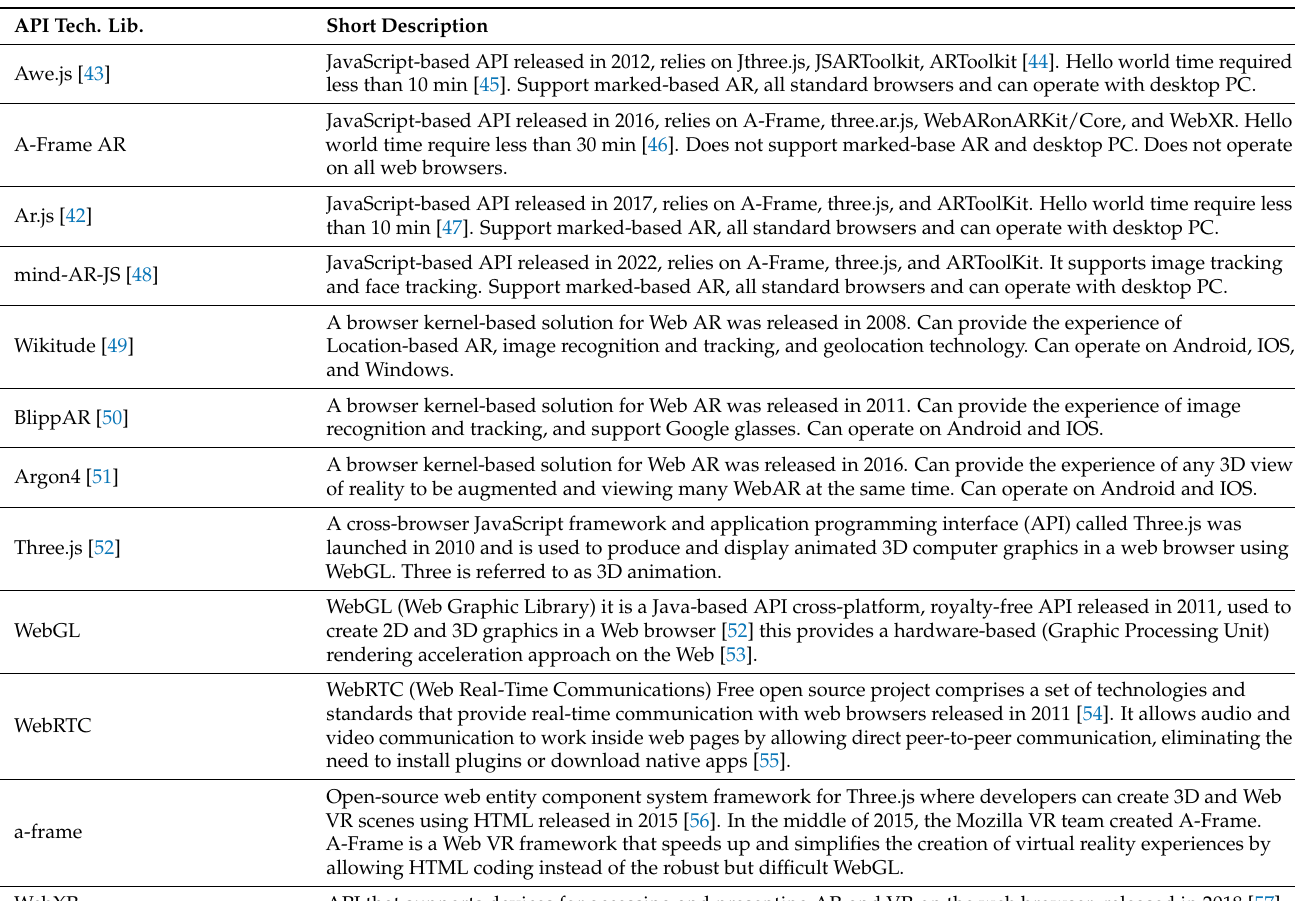
Table 1. Webar Solution and Enabling